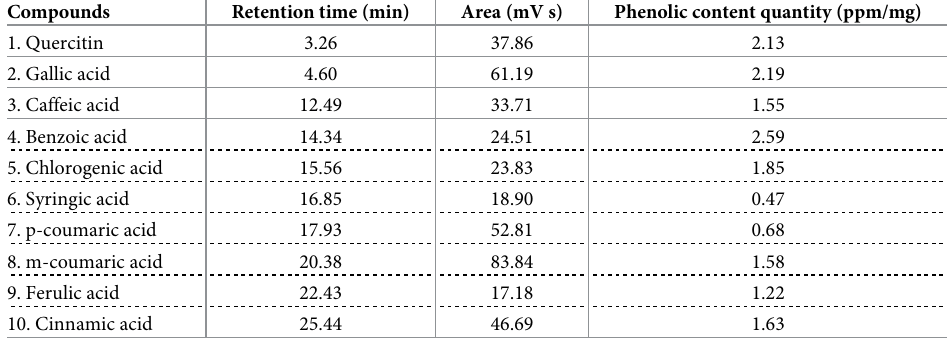
Table 3. The qualitative and quantitative analysis of phenolic compounds in the Euphorbia nivulia Buch.-Ham. butanol extract using HPLC. Compounds